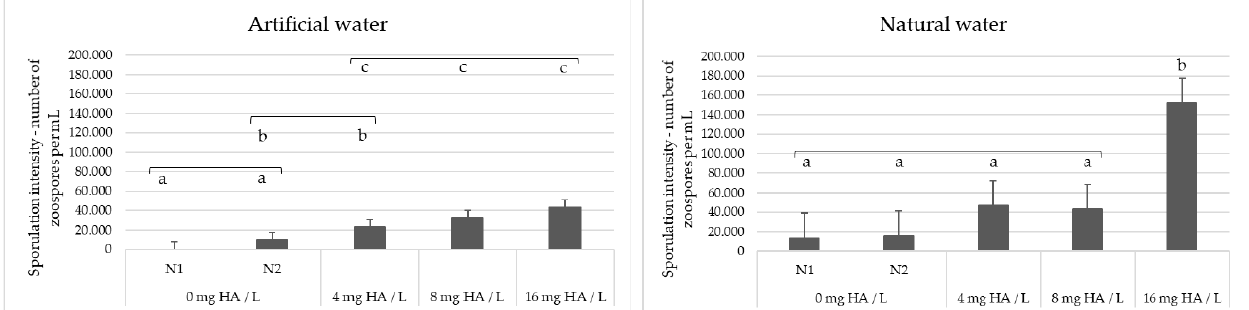
Figure 4. Saprolegnia parasitica sporulation intensity after washing the mycelium with artificial water (AW) or natural water (PF4) supplemented with increasing concentrations of humic acid (HA). In control experiments N1 and N2, water and 0.1 M NaOH were mixed with water samples instead of HA solution in 0.1 NaOH, respectively. Bars marked with the same letter (a, b or c) within each panel are not statistically different from one